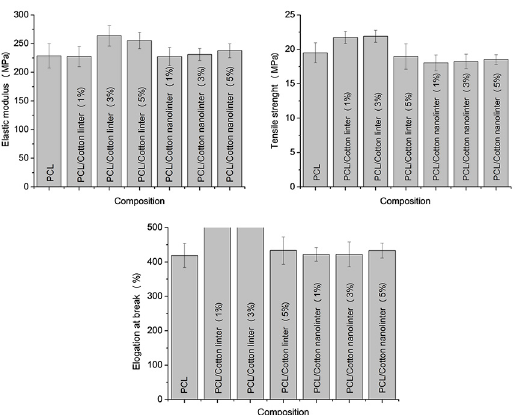
Figure 6: Mechanical properties in tension: Elastic modulus, Tensile strength and Elongation at break of PCL, and PCL/Cotton linter and PCL/Cotton nanolinter compounds. Compositions